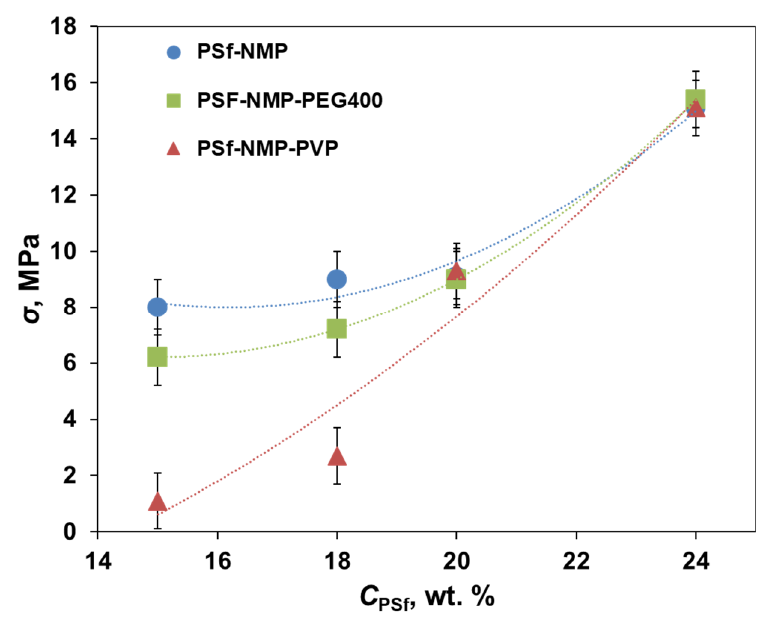
Figure 5. Mechanical properties of short-samples of hollow fiber PSf membranes.